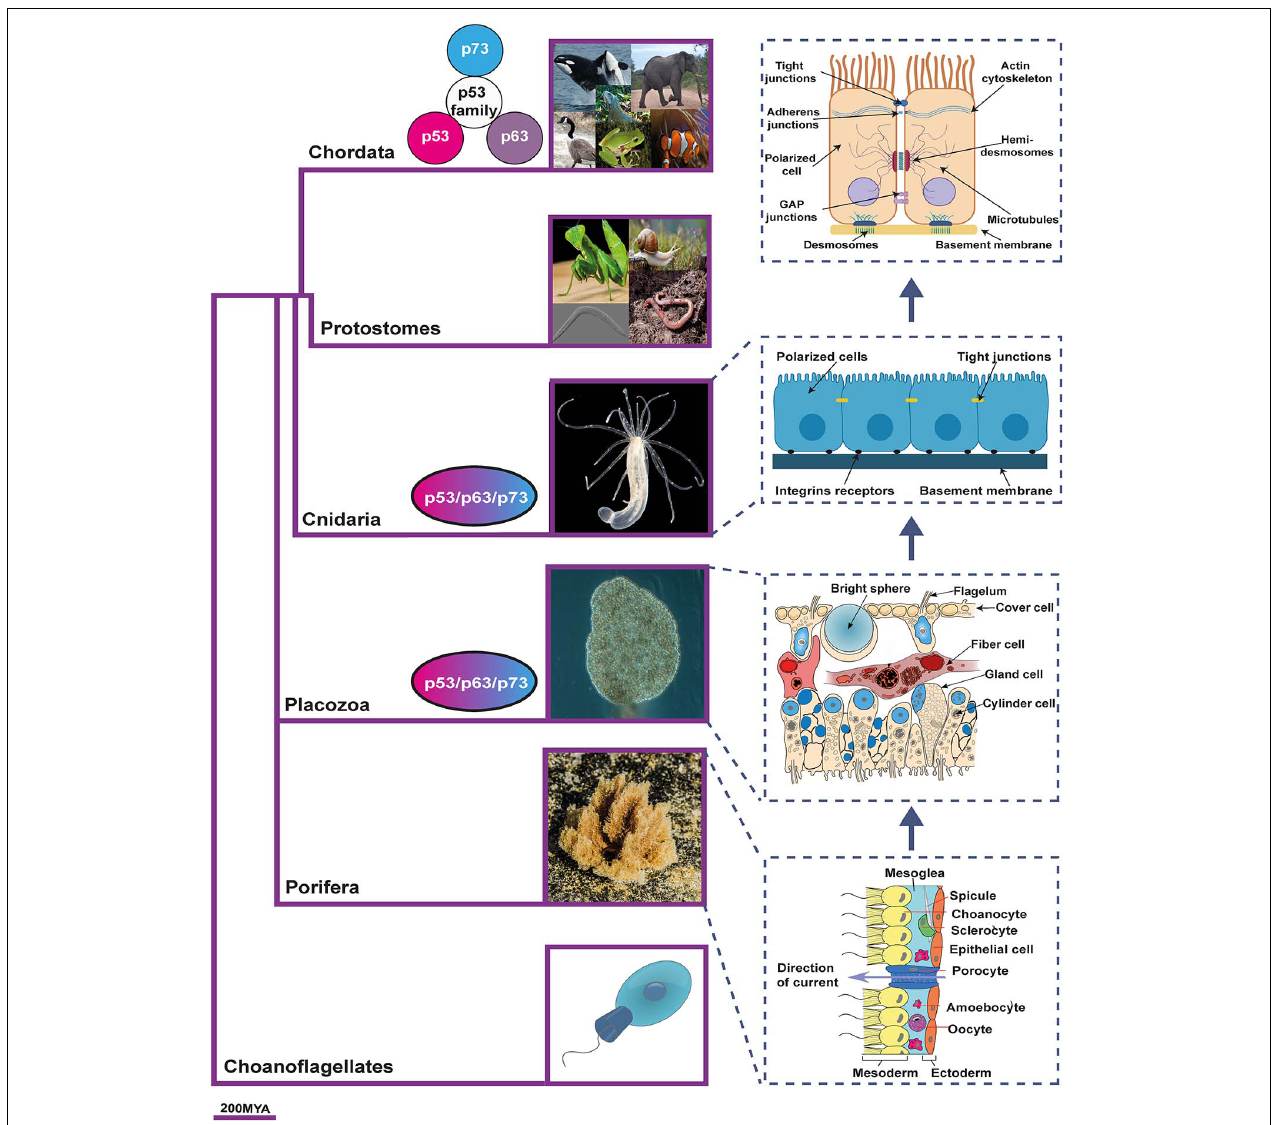
FIGURE 1 | The emergence of epithelia and the proposed relationship with p53 family members phylogeny. p53/p63/p73-ancestor proteins appear for the first time in Placozoan and Cnidaria. Coincidentally, these organisms are the first ones to fulfill the three criteria that distinguish the “true” epithelial phenotype: i) cells displaying aligned polarity; ii) cells connected by belt-forming junctions; and iii) cells associated with extracellular matrix, with a basal lamina. As vertebrates develop, the p53/p63/p73-ancestor gave rise to the three members of the p53 family. The phylogenetic tree is based on Timetree public knowledge-base. The pictures were created with BioRender.com. Photos were a courtesy of Robert Aguilar, Smithsonian Environmental Research Center, United States (https://commons.wikimedia.org/wiki/File:Nematostella_vectensis_(I1419)_999_(30695685804).jpg) and Bernd Schierwater, Institute of Animal Ecology and Cell Biology, Hannover (Germany).